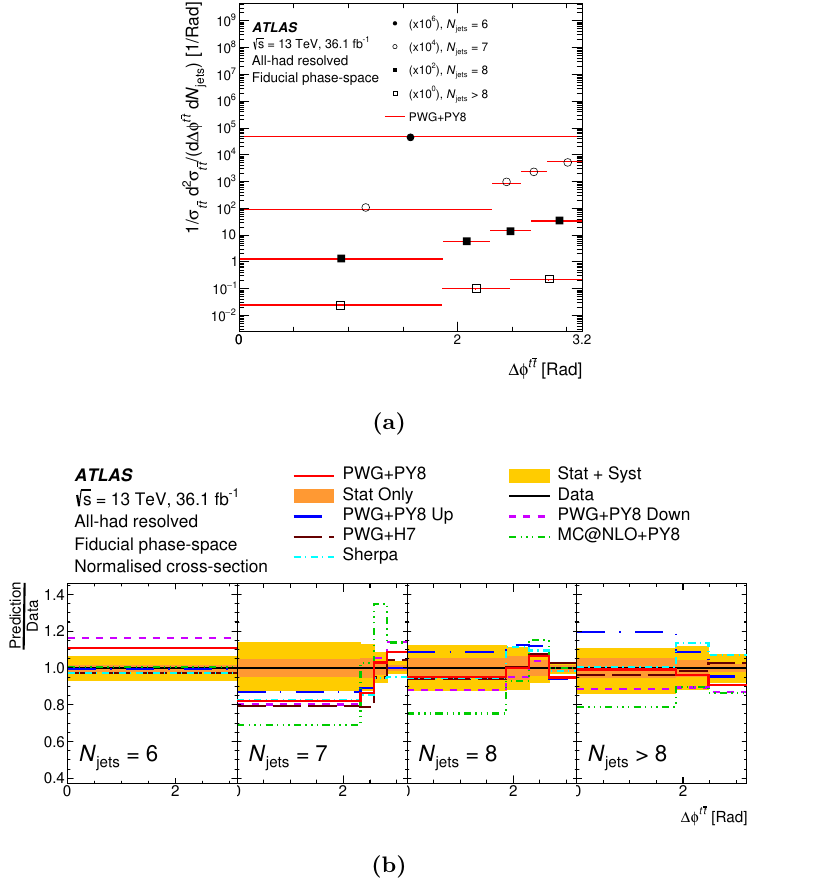
Figure 17 . Particle-level double-differential normalised cross-section (a) as a function of the az- imuthal separation ∆ φ t ¯ t between the top quark and the antitop quark in bins of the jet multiplicity N , compared with the nominal Powheg+Pythia 8 prediction without uncertainties. Data jets points are placed at the centre of each bin. Different markers are used to distinguish the four bins in N , while ∆ φ t ¯ t is shown on the horizontal axis. The ratio (b) of the measured cross-section to jets different MC predictions. Uncertainties are shown by the shaded